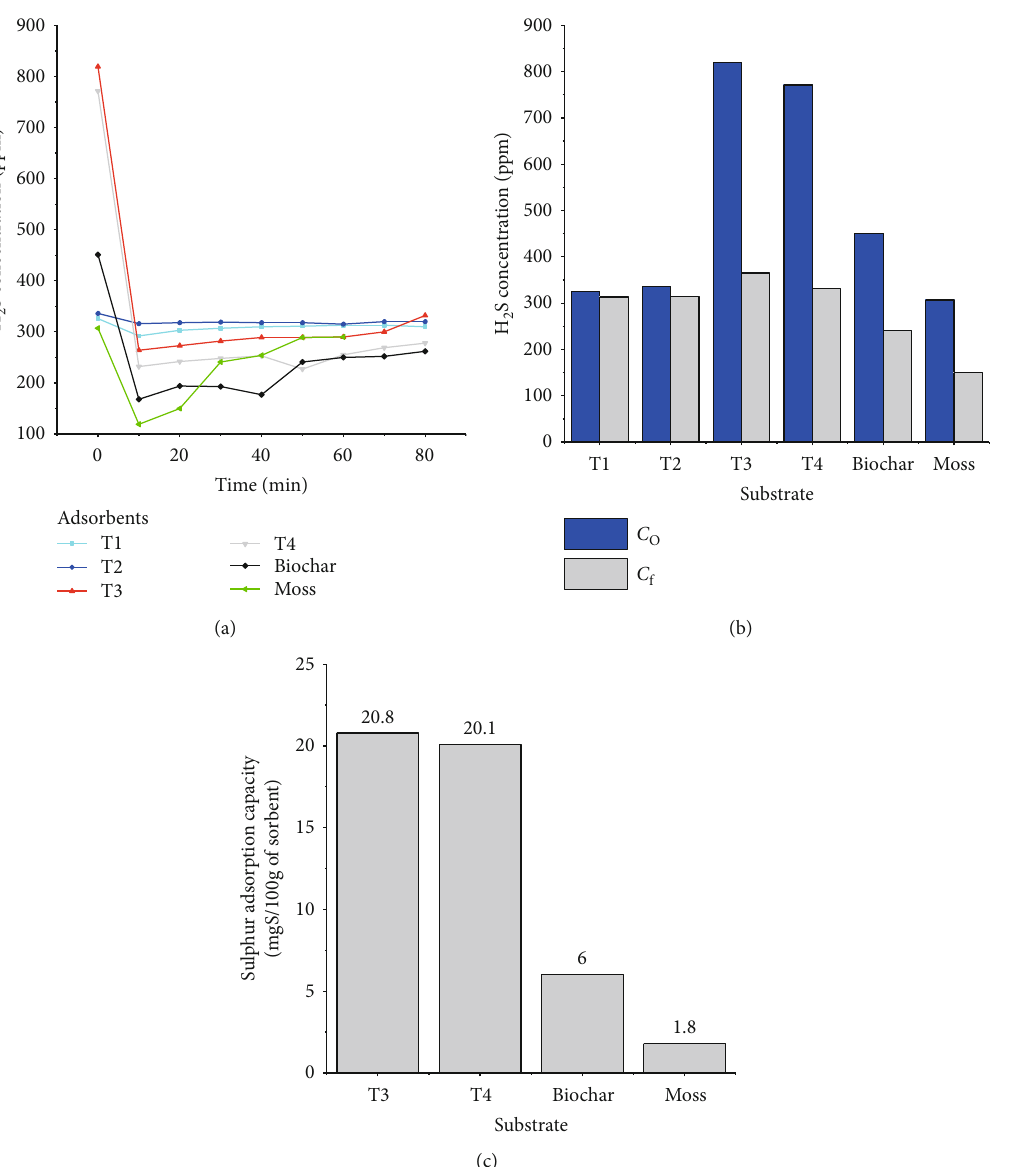
S absorption over breakthrough time, and (c) sorption 2 S, and time = 80 min 2